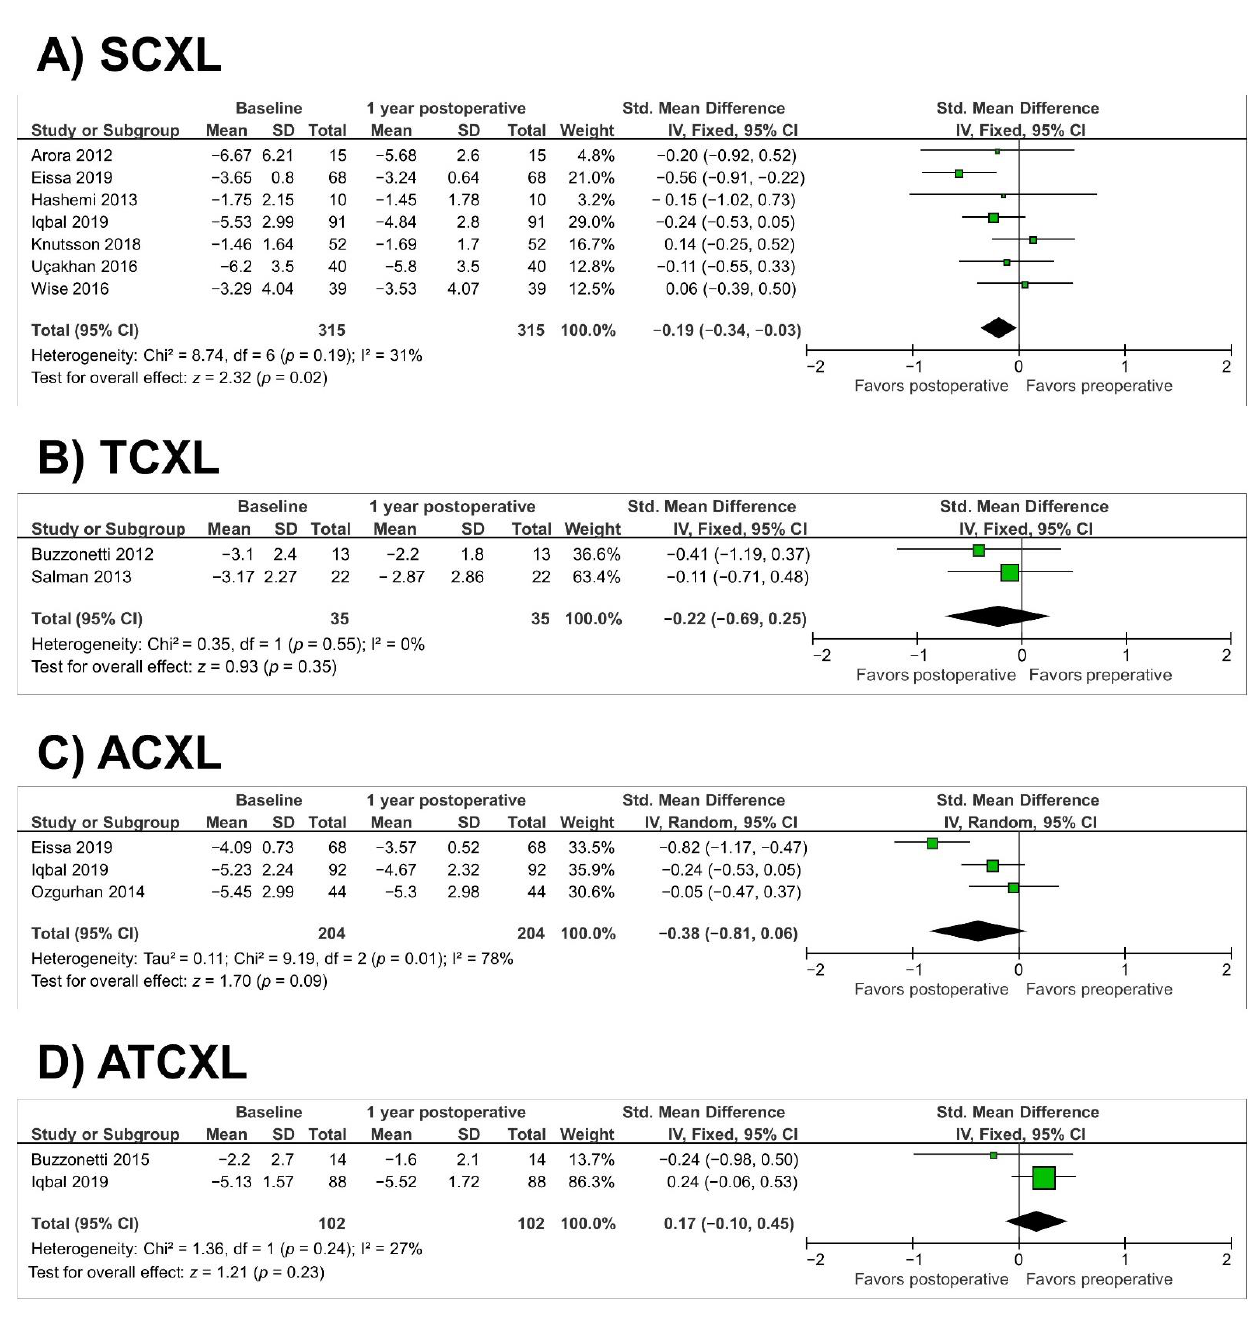
Figure 6. Forest plot of manifest refraction spherical equivalent 1-year standardized mean differences in dioptres in studies included in meta-analysis. ( A ), standard cross-linking (SCXL); ( B ), accelerated CXL (ACXL); ( C ), transepithelial CXL (TCXL), ( D ), accelerated and transepithelial CXL (ATCXL). IV = inverse variance, CI = confidence interval, Tau 2 = tau-square statistic, Chi 2 = chi-square statistic, df = degrees of freedom, I 2 = I-square heterogeneity statistic, z = Z-statistic.